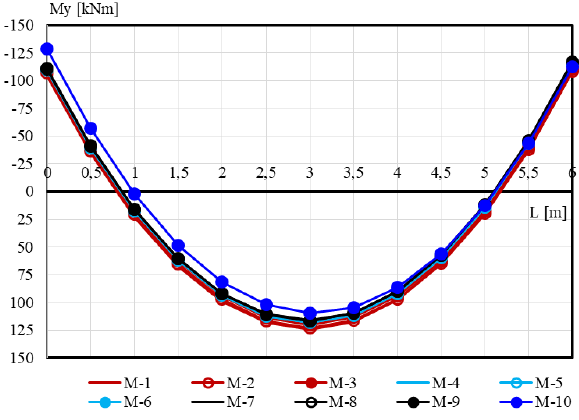
Figure 8: Distribution of bending moments in bridge’s upper floor slab.